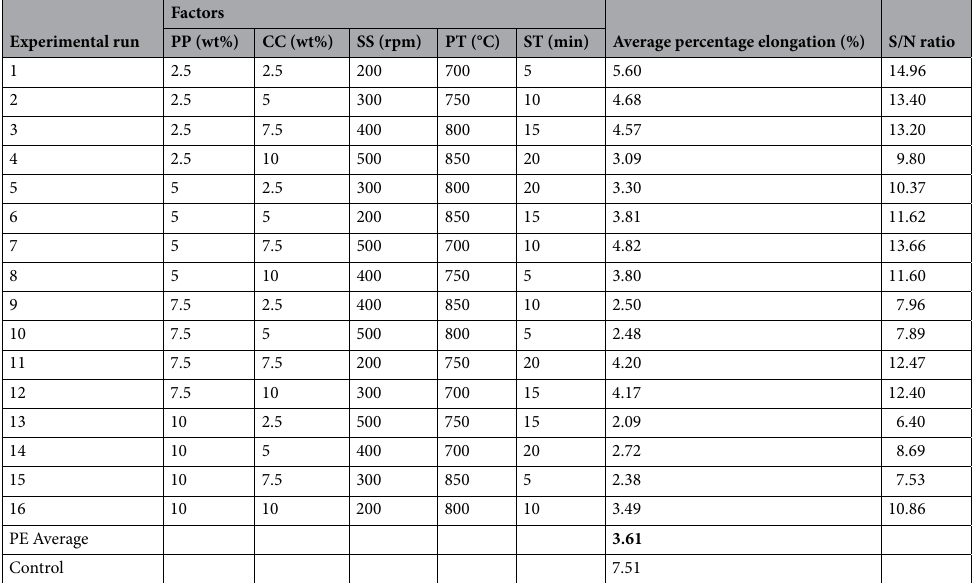
Table 5. Experimental result for percentage elongation of the Al-PP-CCP hybrid composite and the S/N ratio.